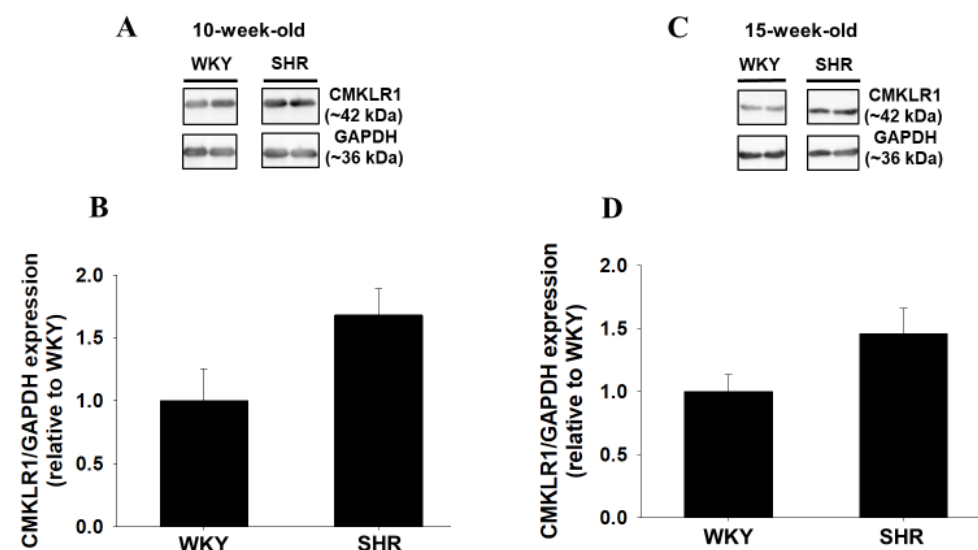
Figure 1. Protein expression of chemokine-like receptor 1 (CMKLR1) around brain ventricles of Wistar Kyoto rats (WKY) and spontaneously hypertensive rats (SHR). Protein expression of CMKLR1 around brain ventricles of male WKY and SHR (( A , B ):10-week-old, ( C , D ): 15-week-old) was determined by Western blotting. Representative blots were shown ( A , C ). The normalized CMKLR1 expression relative to glyceraldehyde 3-phosphate dehydrogenase (GAPDH) expression was shown as relative to WKY. Data were shown as mean + standard error of the mean (SEM) in bar graph (( B ): n = 4, ( D ): WKY; n = 5, SHR; n =